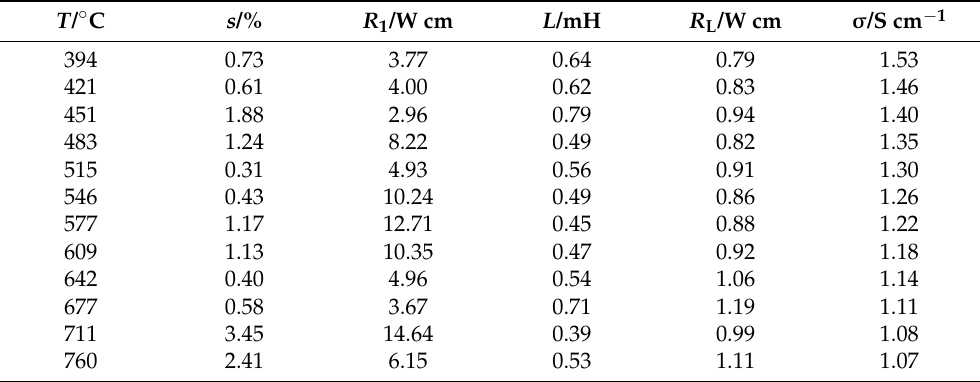
Table 6. Results of fitting the impedance spectra recorded at different temperatures during cooling ( T —temperature; s —standard deviation; fitted parameters (for the EEC presented in Figure 14b): L —inductance; R L and R 1 —resistances; σ —electric conductivity). T / ◦ C